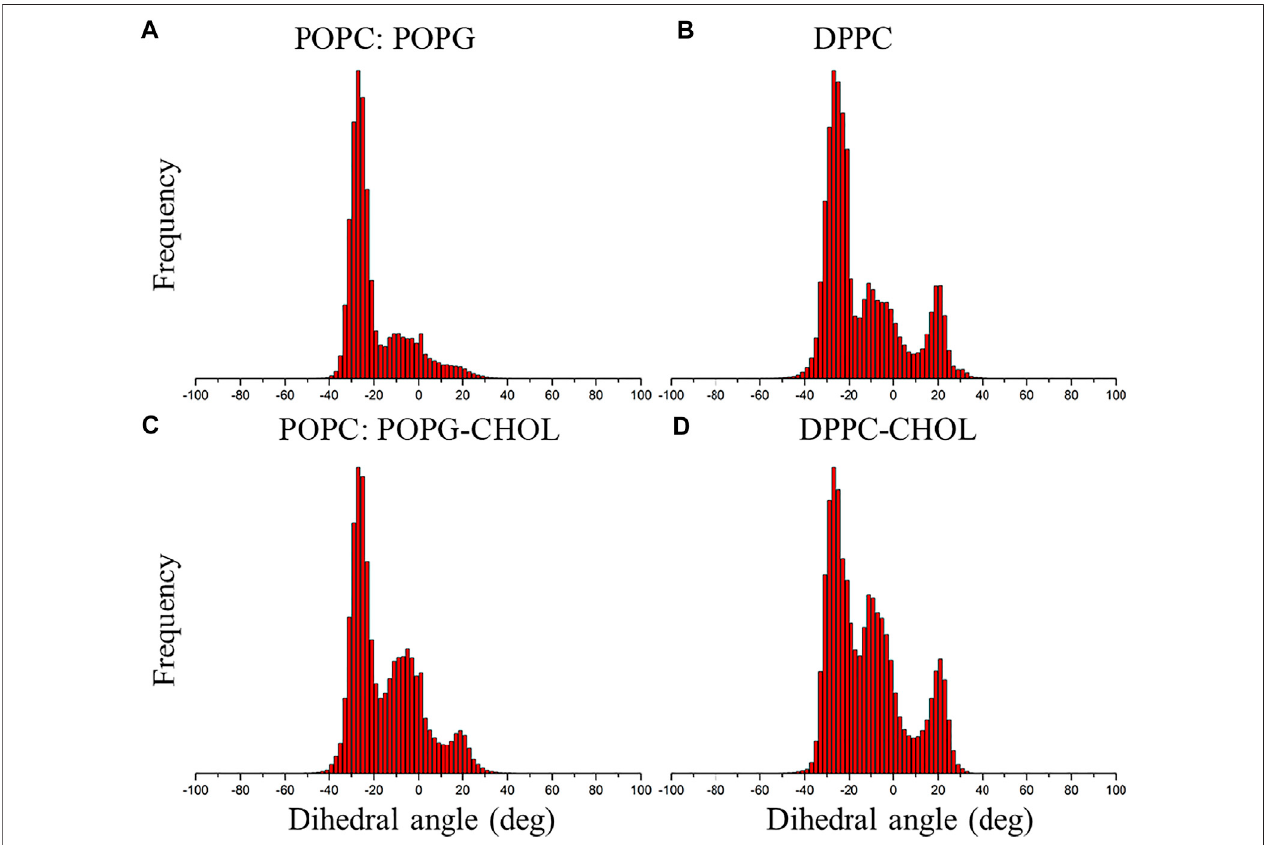
FIGURE 5 | Normalization of the frequency of the dihedral angle of C99 dimer. (A) In POPC:POPG bilayer without cholesterol. (B) In DPPC bilayer without cholesterol. (C) In POPC:POPG bilayer with 20% cholesterol. (D) In DPPC bilayer with 20% cholesterol.